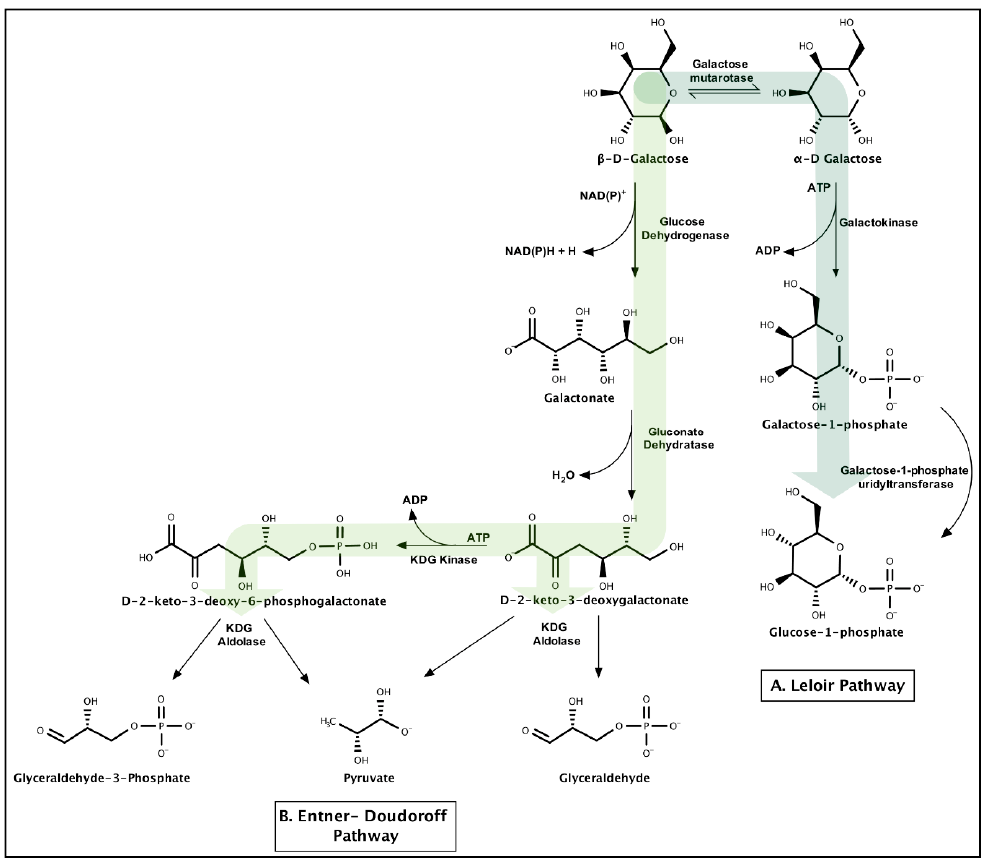
Figure 5. Galactose catabolic pathways. The (A) Leloir pathway generates glucose-1-phosphate for glycolysis, or promiscuous activity of the (B) Entner-Doudoroff pathway enzymes can directly catabolize galactose into pyruvate, glyceraldehyde, and